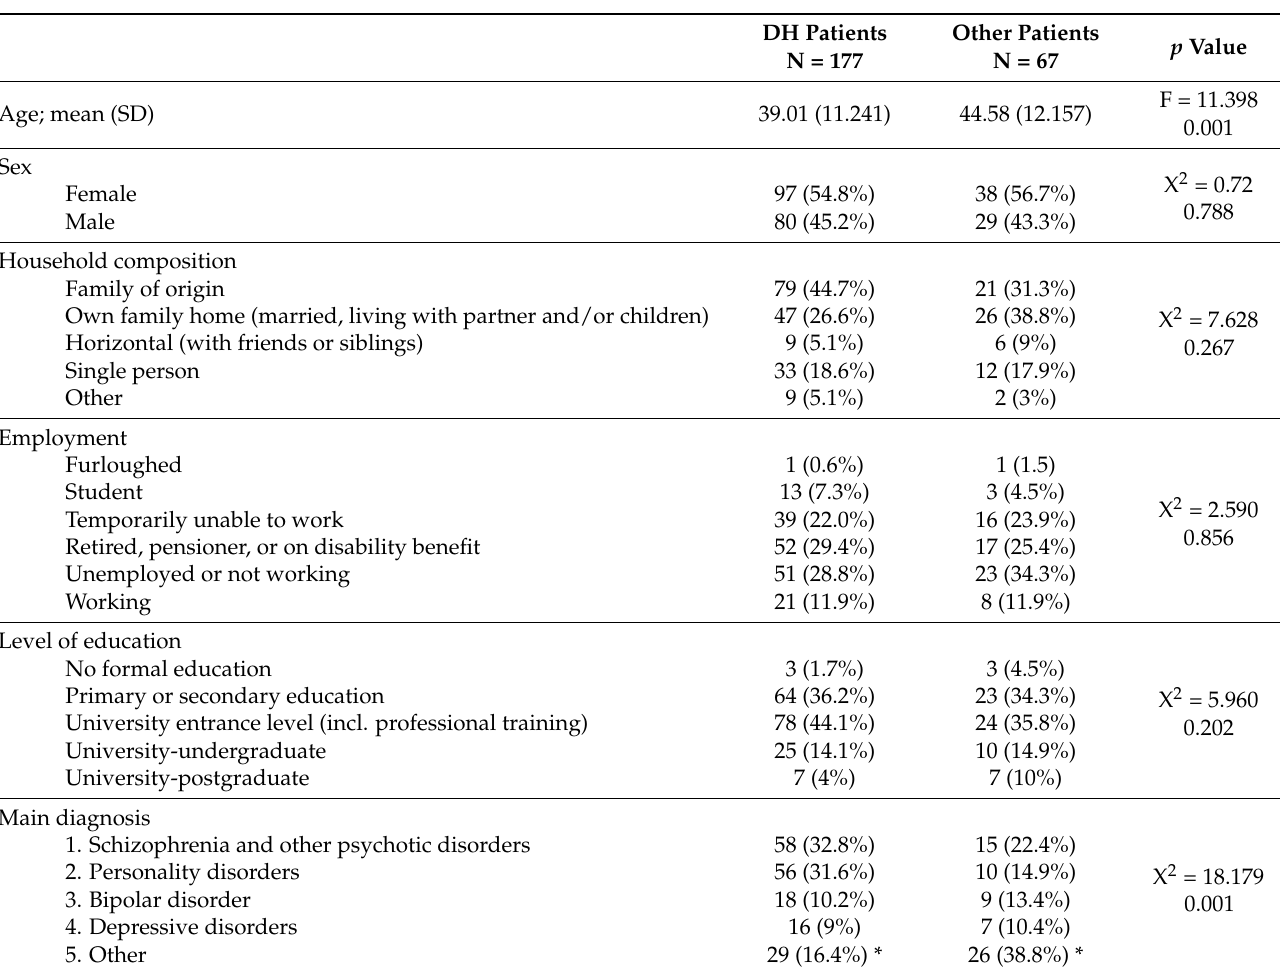
Table 1. Clinical and sociodemographic